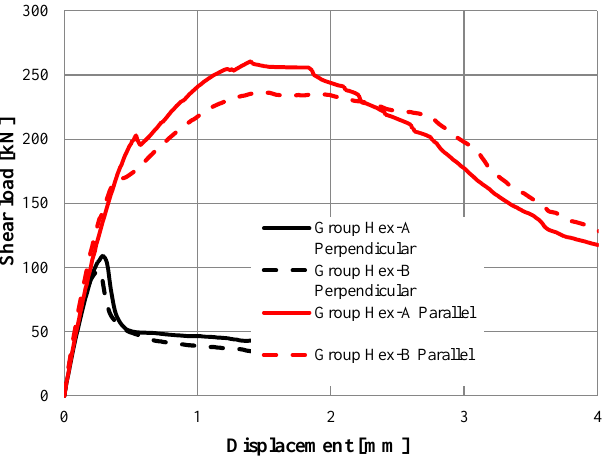
Figure 11. Load-displacement curves obtained for hexagonal groups from numerical